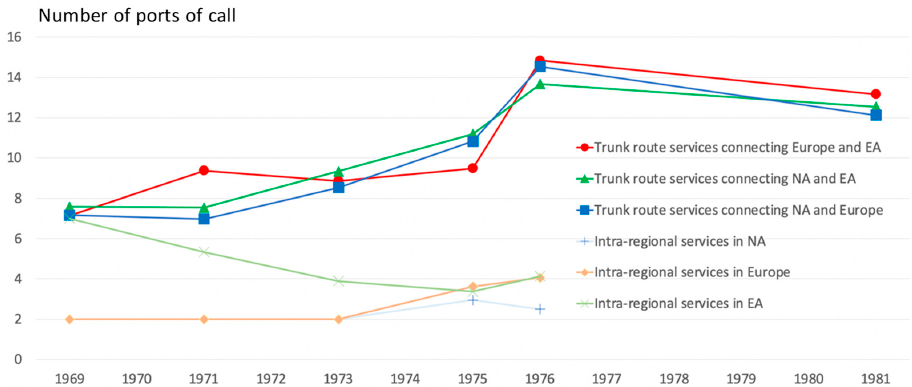
Figure 16. Average number of ports of call per service